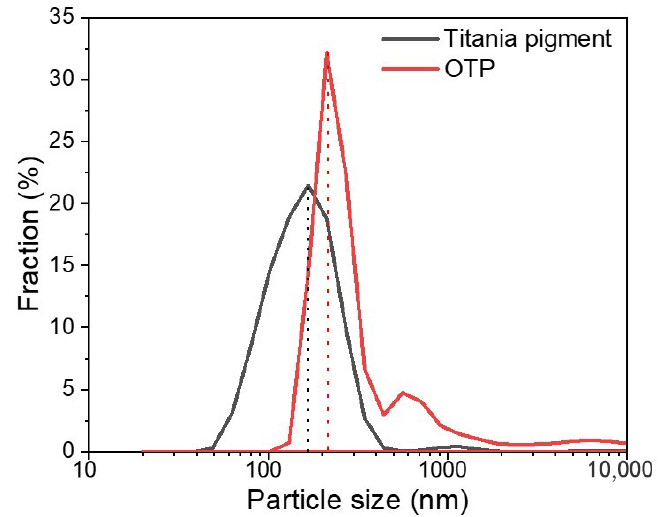
Figure 2. Particle size distribution of titania pigment and OTP in deionized